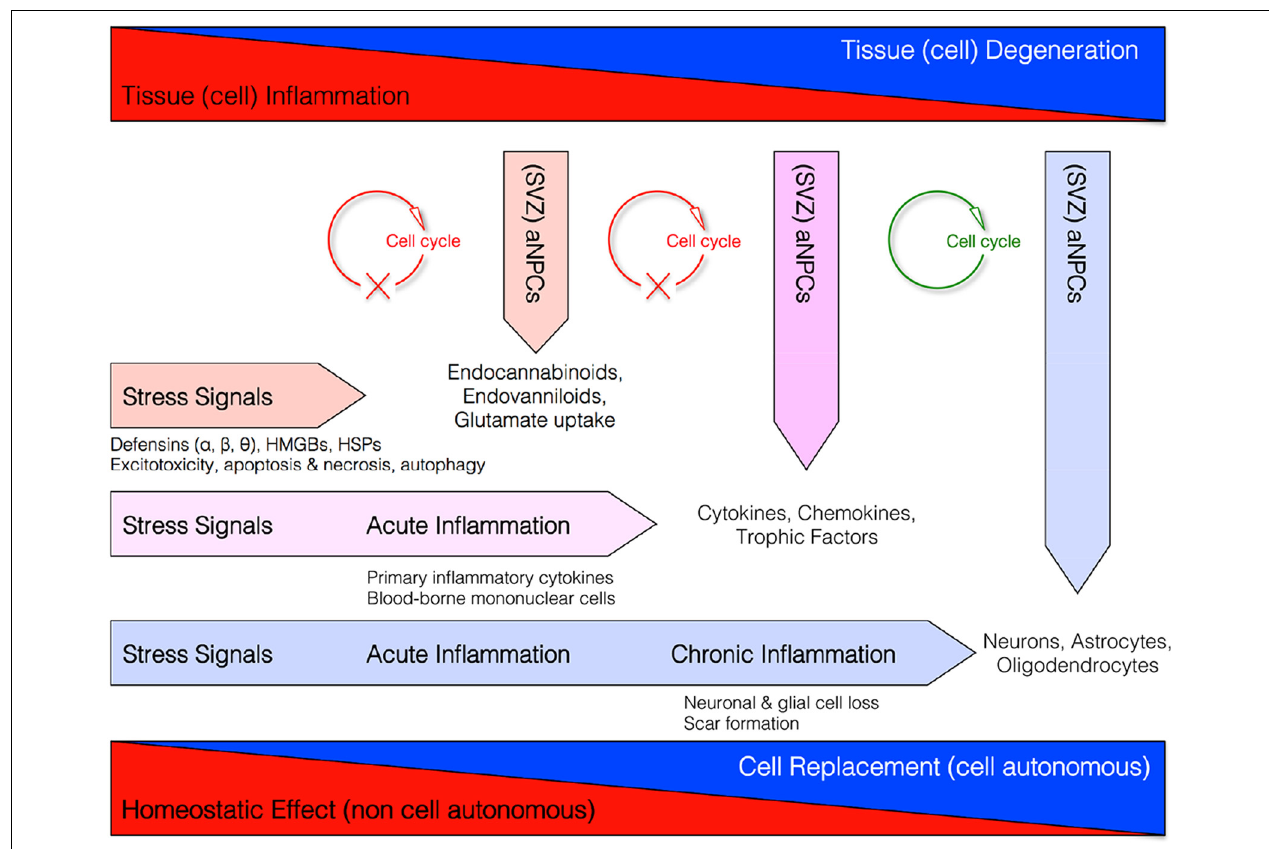
FIGURE 1 | Homeostaticmulti-stepactionsexertedbyendogenousNPCs: from maladaptive (stressful) conditions to pathological chronic tissue damage. Endogenous NPCsadapttheirhomeostaticfunctionstotheneedsof thetissue.Inordertoreduceexcitotoxicitysotopreventreactiveinflammation, endogenous NPCs release neuroprotective molecules (i.e., endocannabinoids, endovanilloids) and increase glutamate uptake as soon as the occurrence of early stress signals. If this barrier fails and acute inflammation occurs,